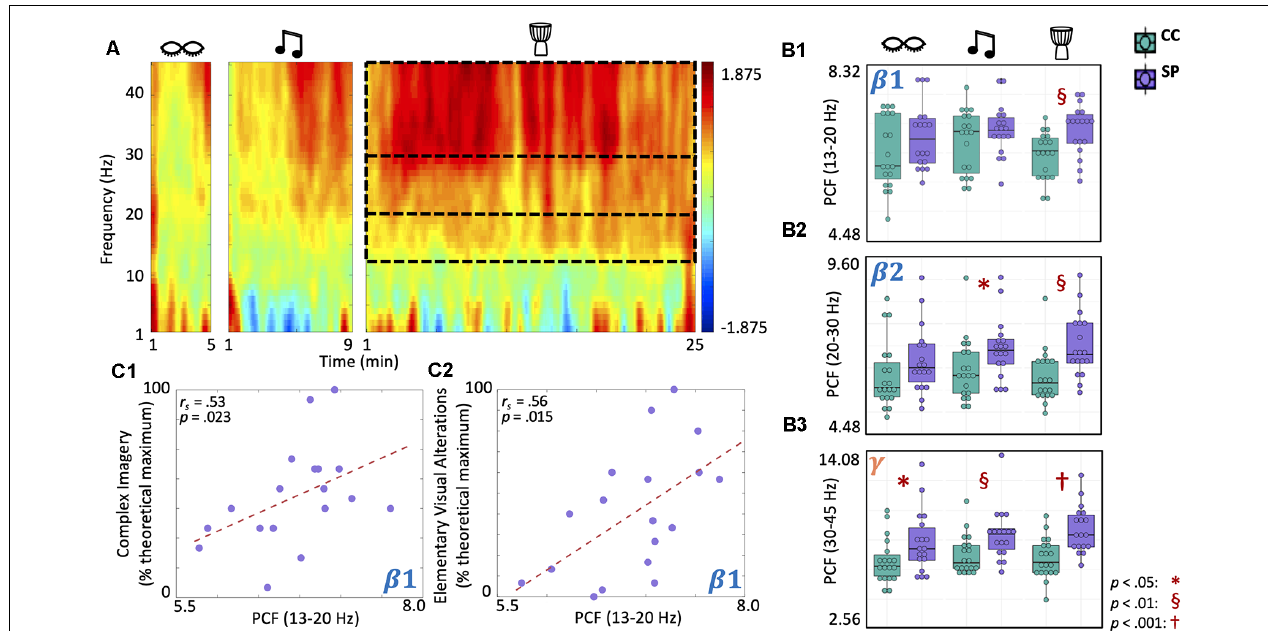
FIGURE 6 | Shamanic practitioners have increased criticality in beta and gamma bands during drumming, with low beta increases correlating with complex imagery and elementary visual alterations. (A) Comparison of criticality, measured using a pair correlation function (PCF), across different frequencies between shamanic practitioners (SP; n = 18) and control participants (CC; n = 19). Warmer colors indicate greater PCF in SP while cooler colors represent increased PCF in CC. Dotted lines represent the low (13–20 Hz) and high (20–30 Hz) beta and gamma (30–45 Hz) bands, which were significantly different between SP and controls. (B1–B3) Box plots illustrating the average PCF value for the low (B1) and high (B2) beta and gamma (B3) bands in SP (purple) and CC (green) during eyes closed, classical music, and drumming. Whiskers represent the lower (25%) and upper (75%) quartiles and the center band of each box represents the median for the group. SP had greater PCF in the low and high beta (B1,B2) and gamma (B3) bands during drumming compared to CC, with increases extending to the classic music condition in high beta (B2) and gamma (B3) bands and the eyes closed condition in the gamma band (B3) . Significance is indicated by the key in the lower righthand corner. (C1,C2) Spearman correlations revealed a positive correlation between PCF in the low beta band and both complex imagery (C1) and elementary visual alterations (C2)